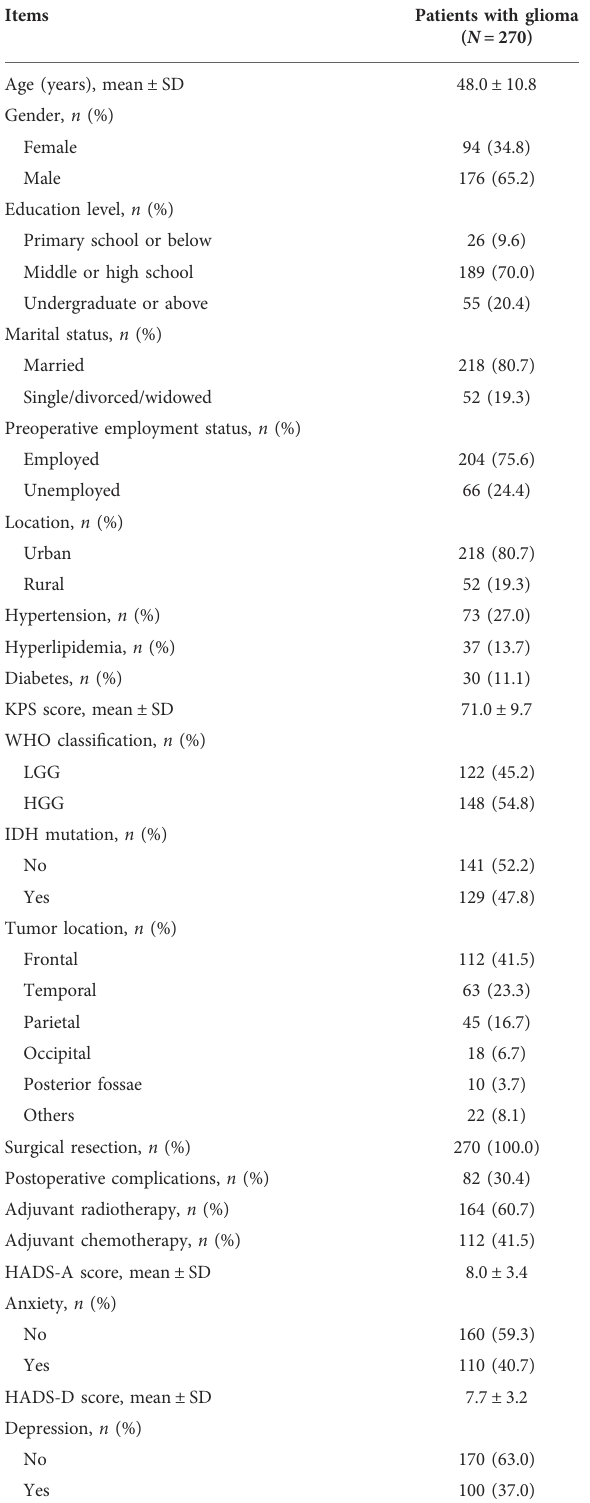
TABLE 1 Baseline